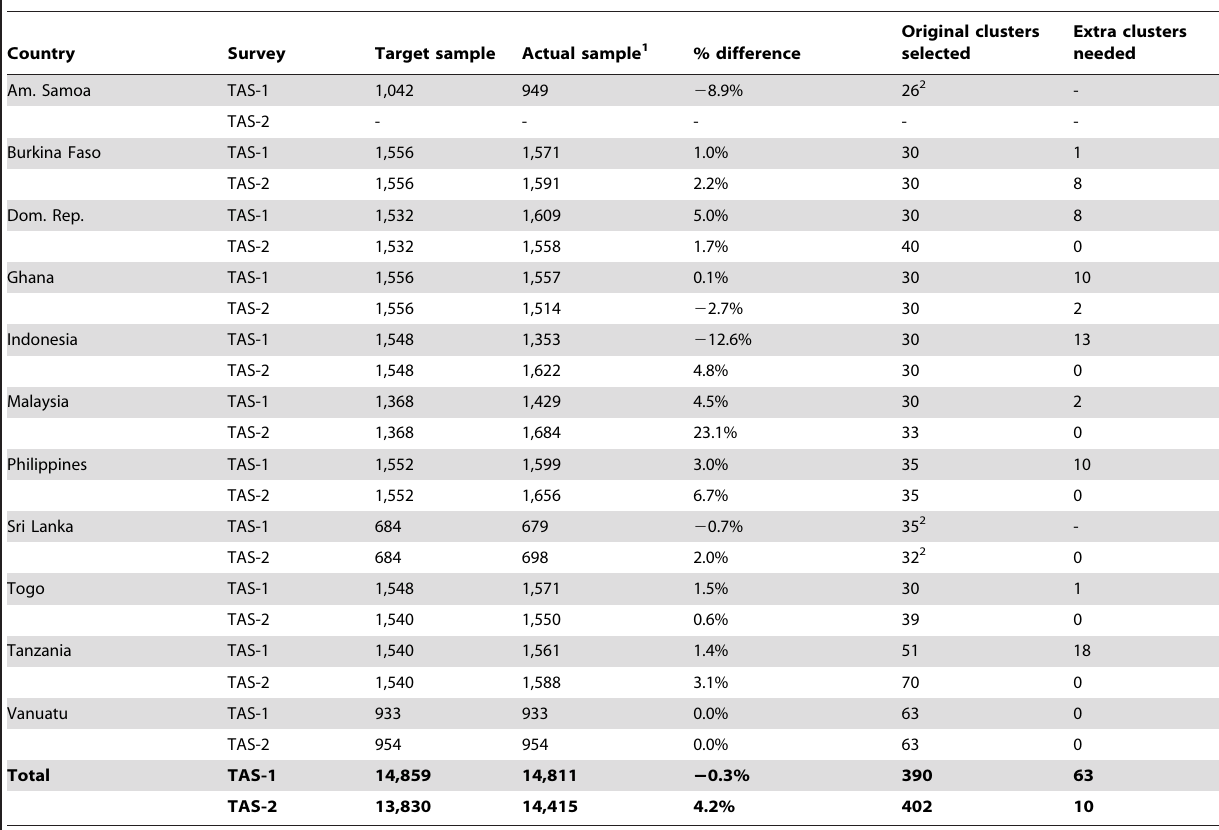
Table 7. Comparison of target and actual sample sizes and number of clusters.